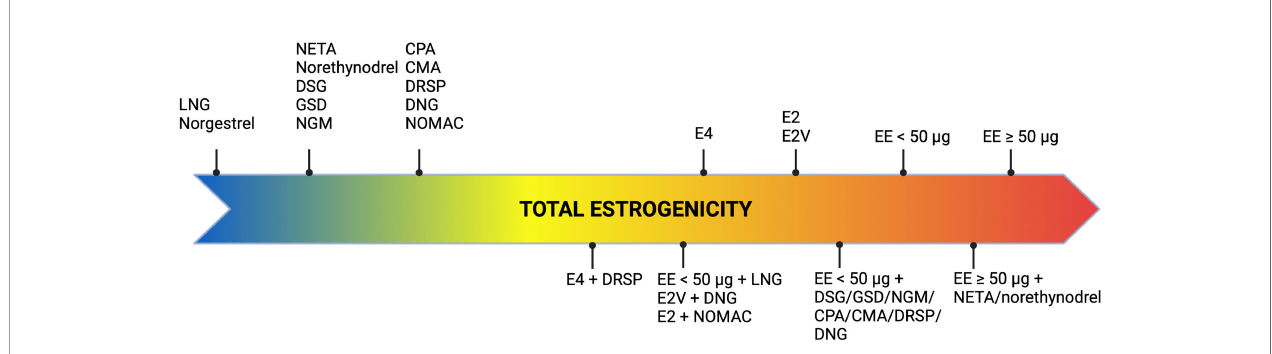
FIGURE 3 | Concept of estrogenicity with combined oral contraceptives. CMA, chlormadinone acetate; CPA, cyproterone acetate; DNG, dienogest; DRSP, drospirenone; DSG, desogestrel; EE, ethinylestradiol; E2, estradiol; E2V, estradiol valerate; E4, estetrol; GSD, gestodene; LNG, levonorgestrel; NETA, norethisterone acetate; NGM, norgestimate; NOMAC, nomegestrol